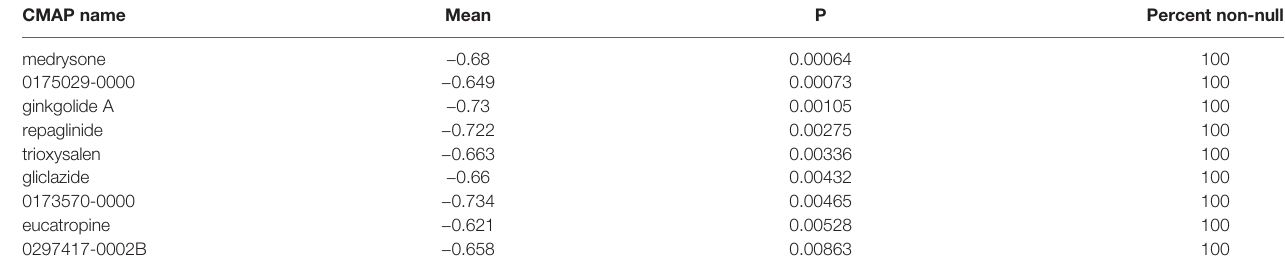
TABLE 3 | Eight candidate drugs of connectivity map analysis.